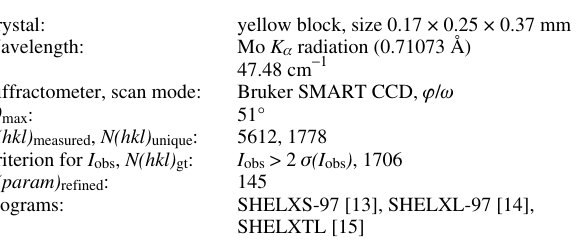
Table 1. Data collection and